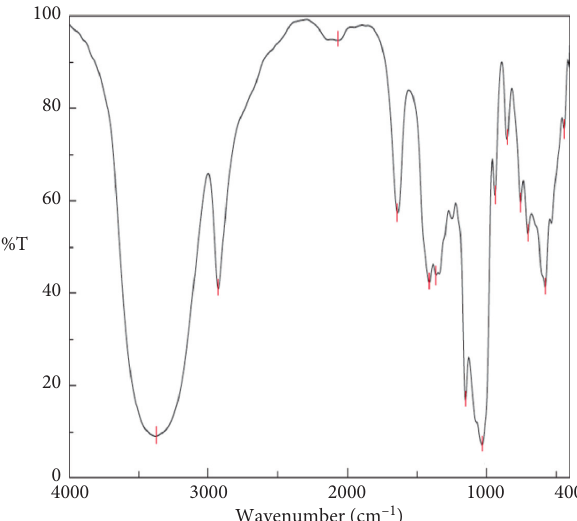
Figure 1: The FT-IR spectra of the AgNPs (a) and β